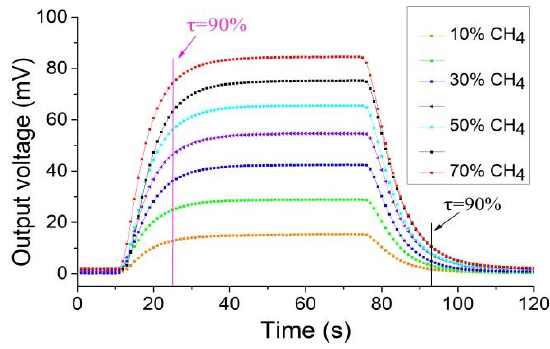
Figure 7. The response-recovery curve of the thermal conductivity sensor.